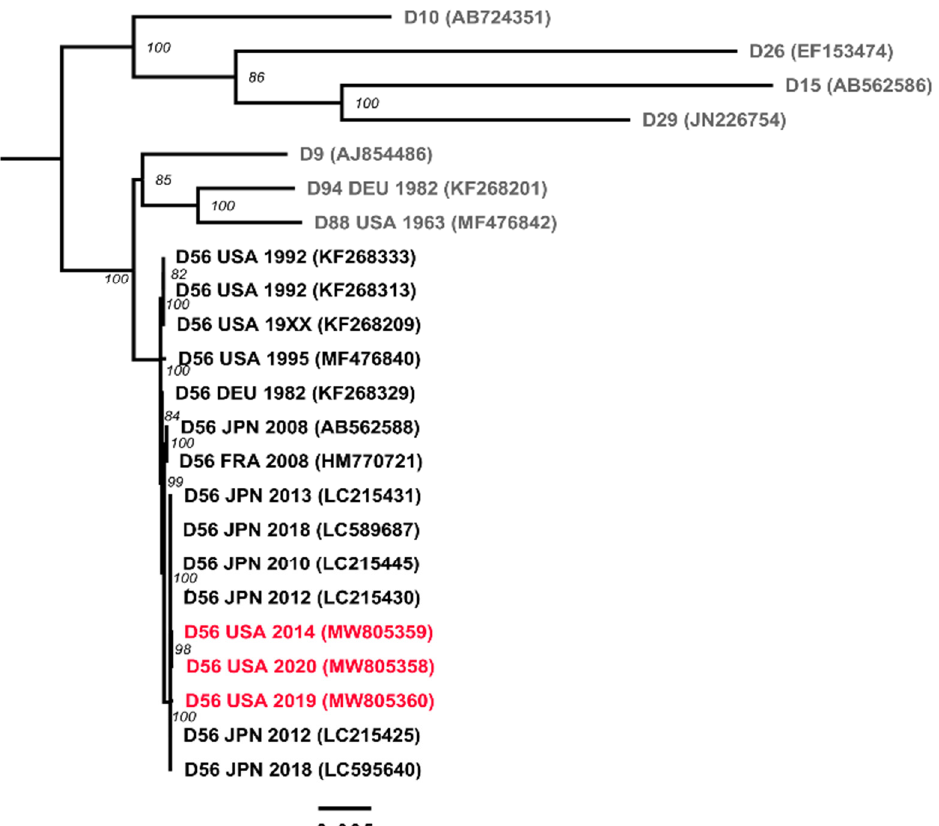
Figure 1. Phylogenetic analysis of the whole genome sequences of USA strains NCH-Pro95/2014, IDR1900044114 and VIR209329 (in red font), previously identified strains of HAdV-D56, and closely related HAdV-D genotypes -D9, -D10, -D15, -D26, -D29, -D88, and -D94. Maximum likelihood phylogenetic tree of types HAdV-D9, -D10, -D15, -D26, -D29, -D56, -D88, and -D94. The bootstrap support is shown next to the branching nodes. The length of the branches represents the number of mutations per nucleotide site according to the scale.